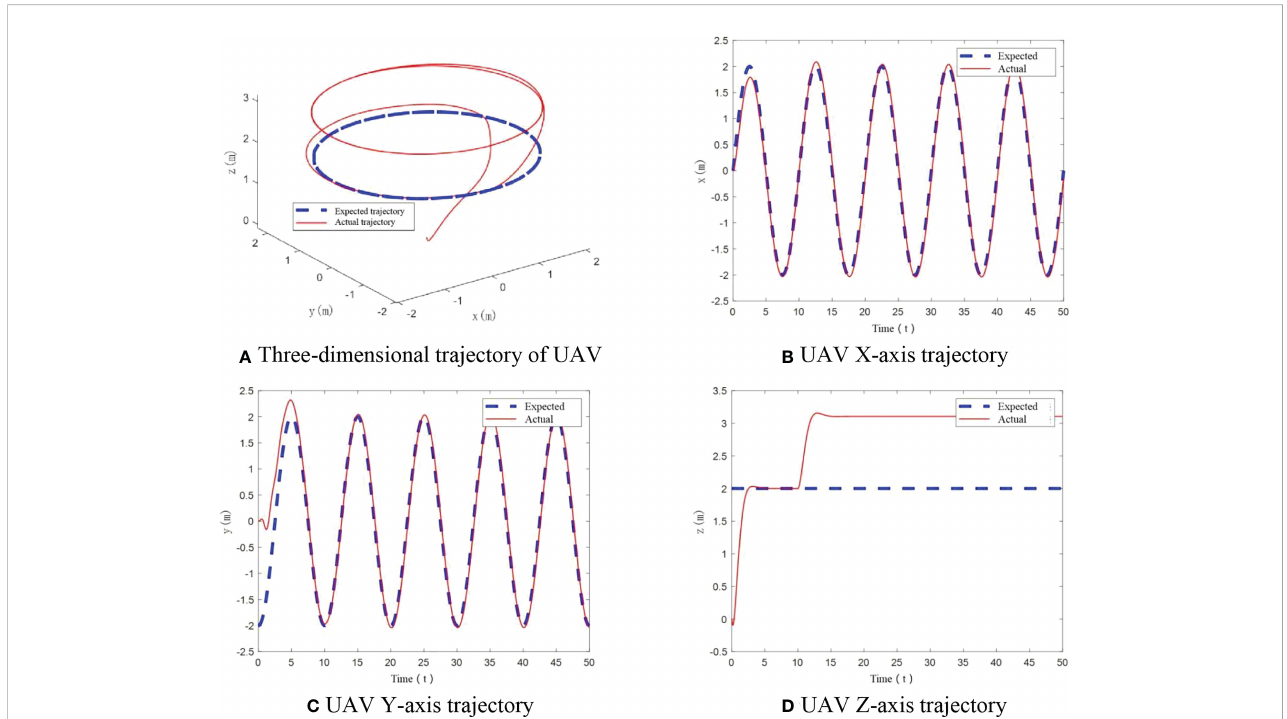
FIGURE 8 UAV fl ight trajectory with small mass change. (A) Three-dimensional trajectory of UAV, (B) UAV X-axis trajectory, (C) UAV Y-axis trajectory, (D) UAV Z-axis trajectory.